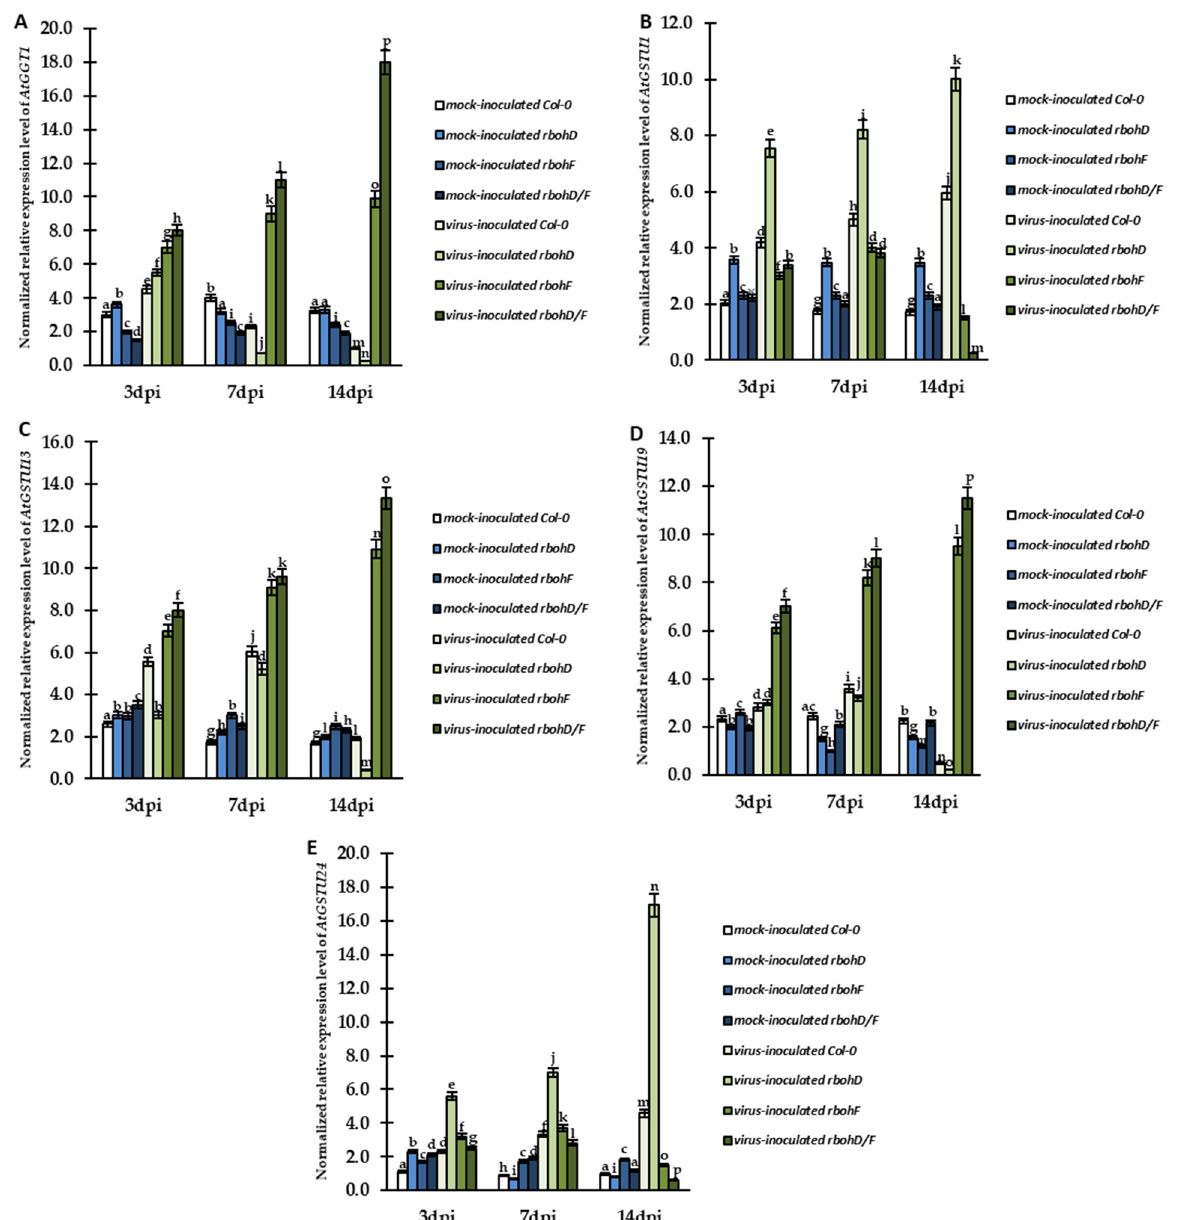
Figure 8. The normalized relative expression levels of AtGGT1 ( A ), AtGSTU1 ( B ), AtGSTU13 ( C ), AtGSTU19 ( D ), and AtGSTU24 ( E ) calculated based on the mean expression of AtEf1 α and AtF-Box reference genes in mock- and virus-inoculated Col-0, rbohD , rbohF, and rbohD/F plants between 3 and 14 dpi. The mean values of the normalized expression levels were calculated and analyzed using ANOVA and Tukey’s HSD test at p < 0.05. Statistically significant values are indicated by different letters above the